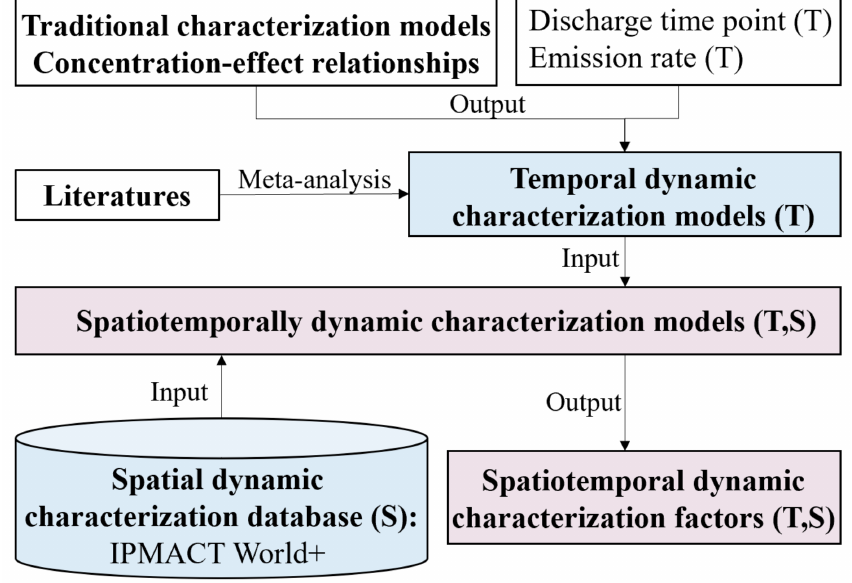
Figure 3. Dynamic quantification flowchart for establishing dynamic characterization